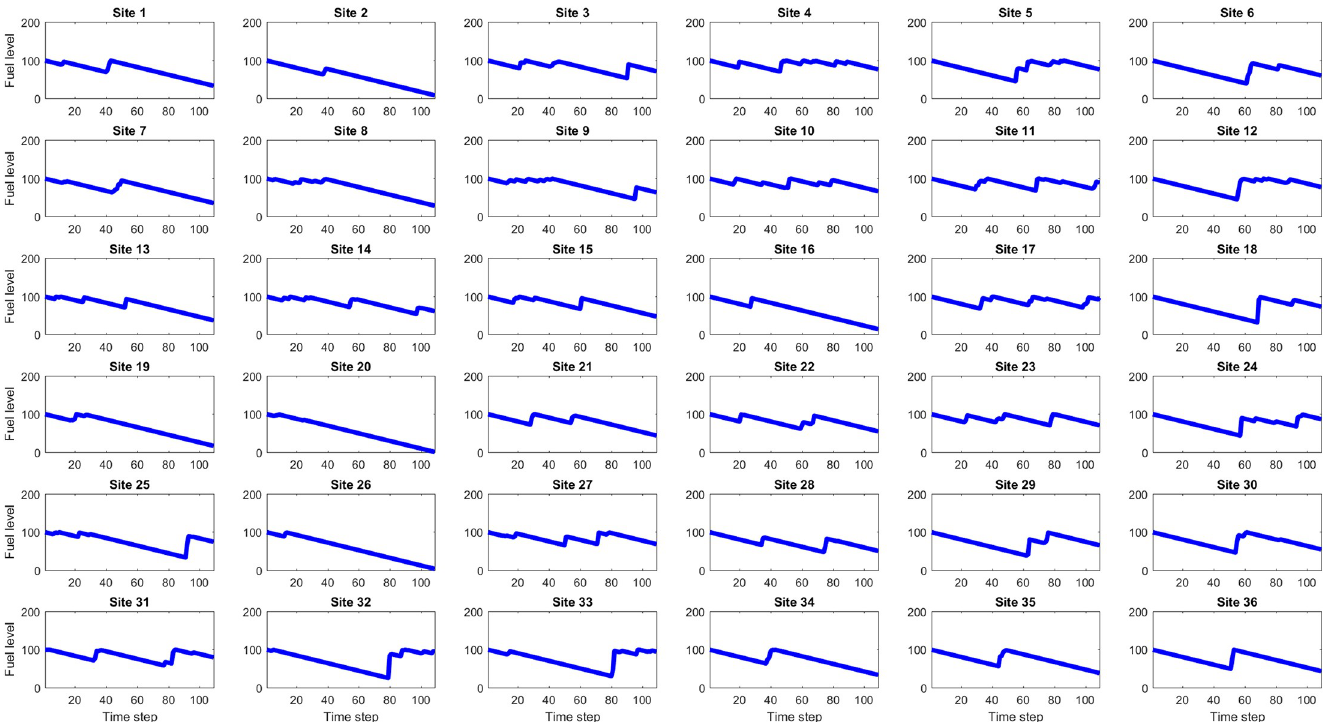
Fig 13. Time series of site fuel unit values, for 100 initial (and maximum) fuel units case. The longer simulation run times made possible by the higher initial site fuel value gives the assets more time to refuel sites.